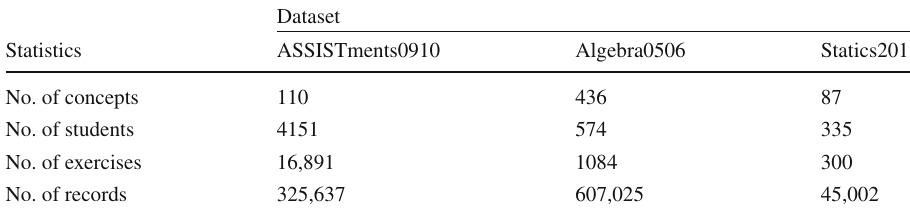
Table 1 Summary of experiment datasets (After